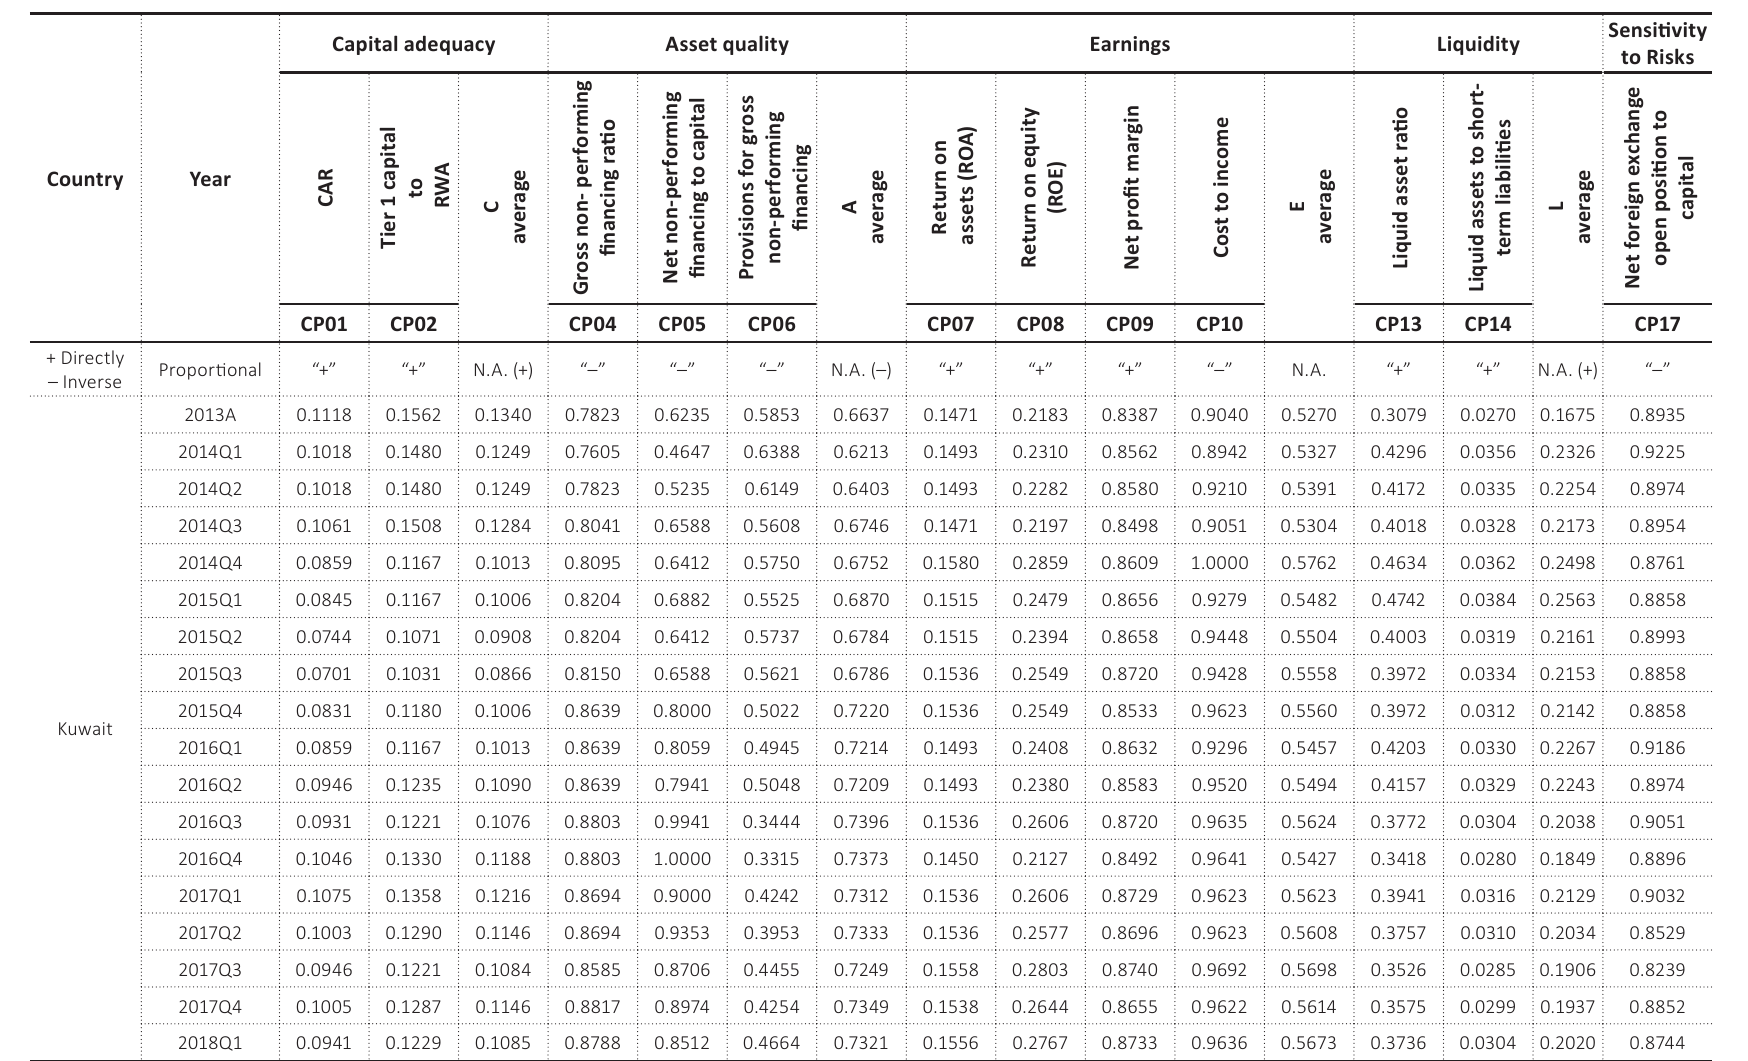
Table A3. Standard CAELS data of Kuwait